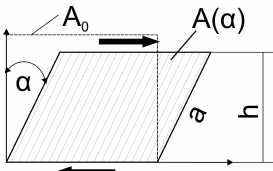
Figure 3. Shear frame mechanism inducing a pure shear strain state with shear angle α , initial edge length a and deformed height h .